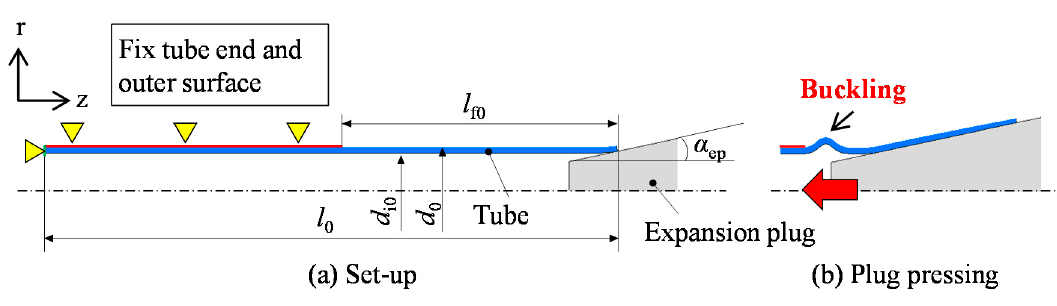
Figure 4. Two-dimensional implicit model for flaring (FL-2D-Impl) for FEM analysis. Table 1. Process conditions for tube flaring.